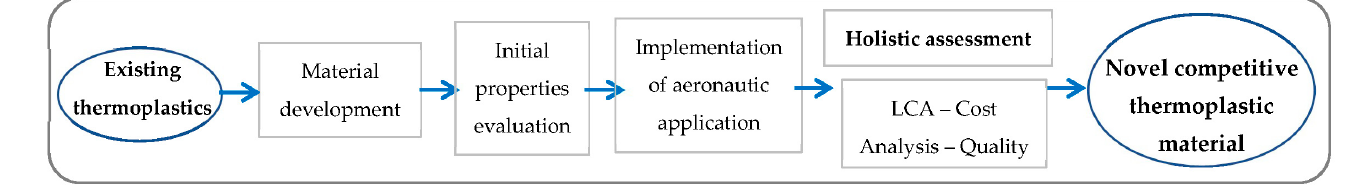
Figure 1. Flow diagram of methodology used.